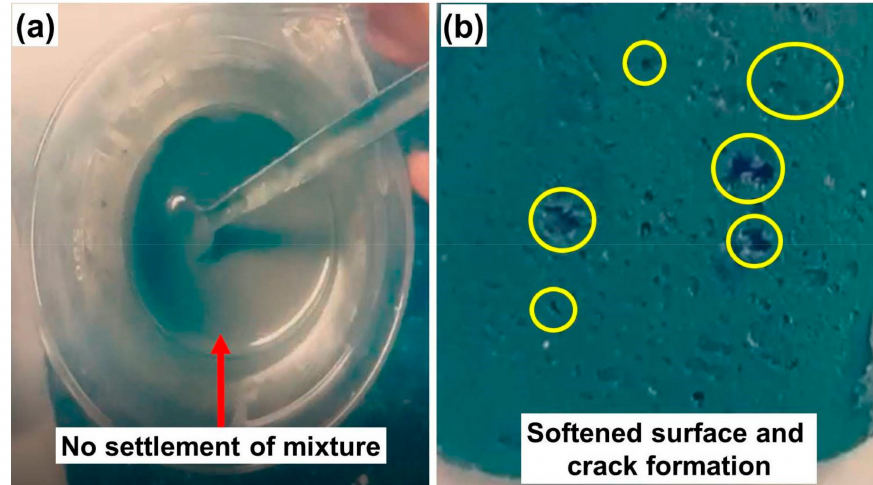
Figure A4. Challenges during composite preparation for ( a ) TC6 and ( b )